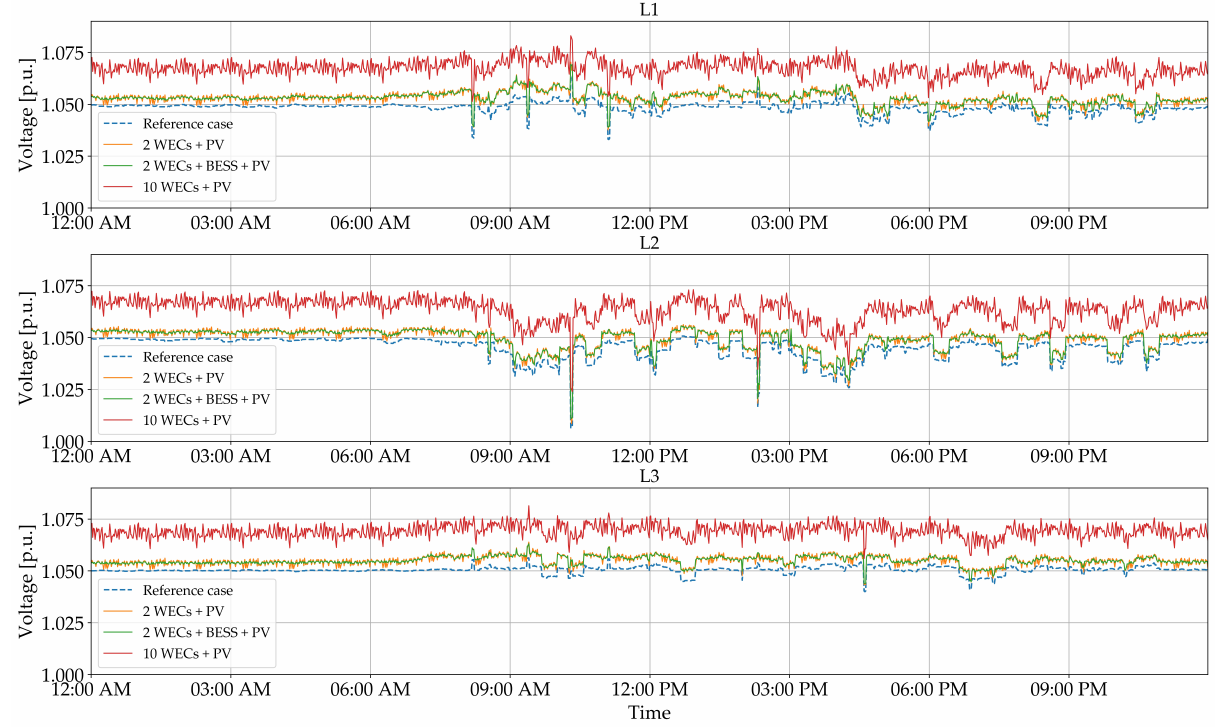
Figure 20. Voltage profiles at the WPF PCC bus for various scenarios in case study